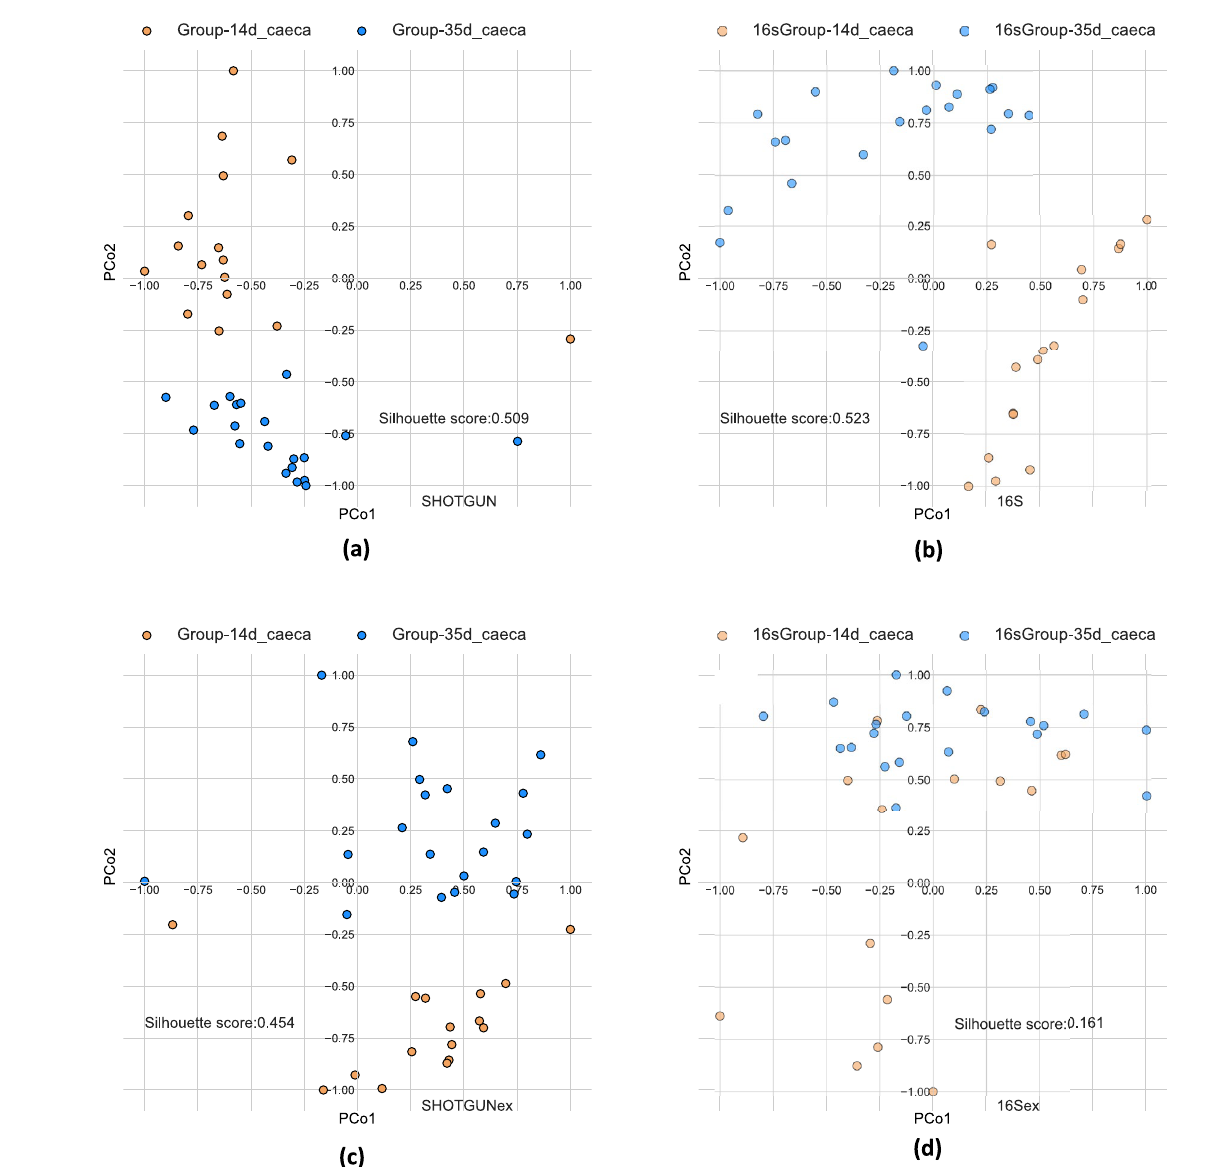
Figure 7. PCoA based on the beta-diversities between samples (Bray–Curtis metric), computed on genera abundances of caeca samples normalized by DESeq2, labelled by sampling time: 14th day (gold), 35th day (cyan). ( a , b ) with all genera detected respectively by shotgun ( a ) and 16S ( b ); with genera found exclusively by shotgun ( c ) or 16S ( d